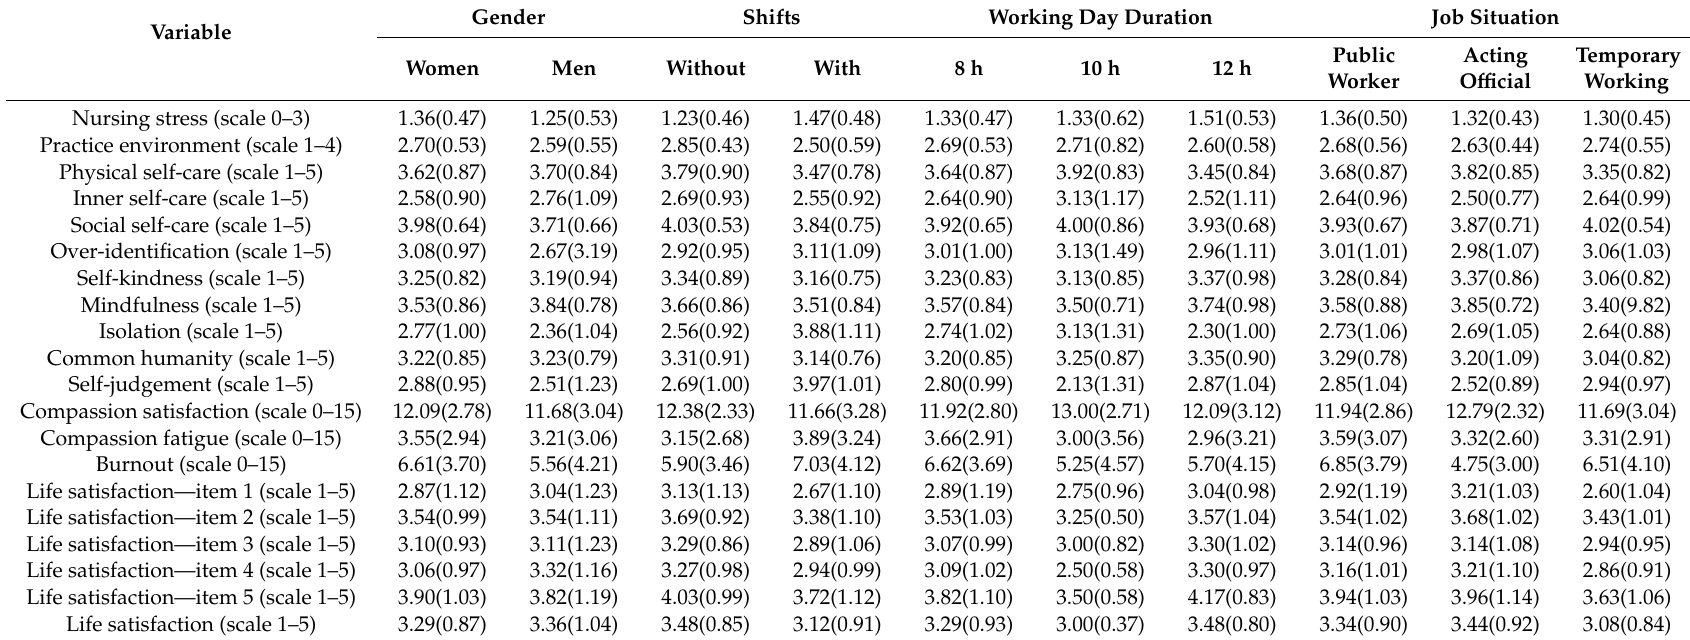
Table 3. Means and standard deviations of the variables under the study for demographic and work conditions